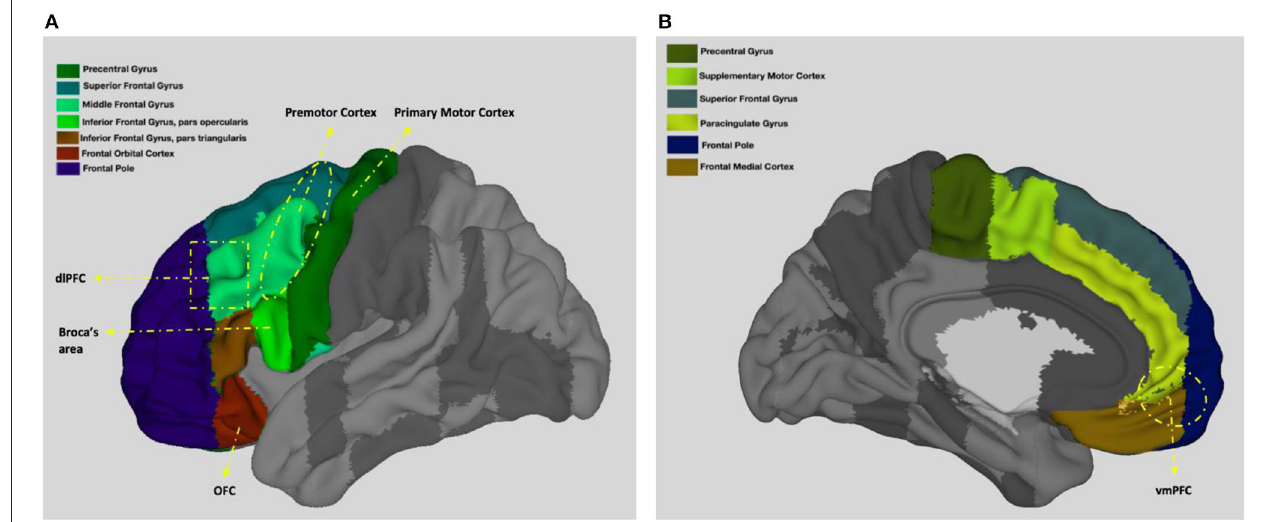
FIGURE 2 | Neuroanatomy of the frontal lobes. (A) presents left view and (B) presents right view. Adapted from the Harvard-Oxford atlas developed at the Center for Morphometric Analysis (CMA), and distributed with the FMRIB Software Library (FSL) (Bakker et al., 2015), 3D Surface View (Majka et al.,